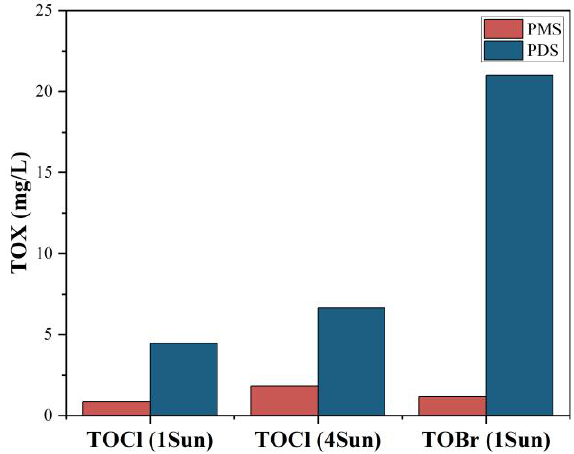
Figure 6. Total organic halogen (TOX) concentration in condensed freshwater with the addition of PMS and PDS under different solar intensities. Experimental conditions: [Phenol] 0 = 10 mg/L, [PMS] = 1 mmol/L, [PDS] = 10 mmol/L.